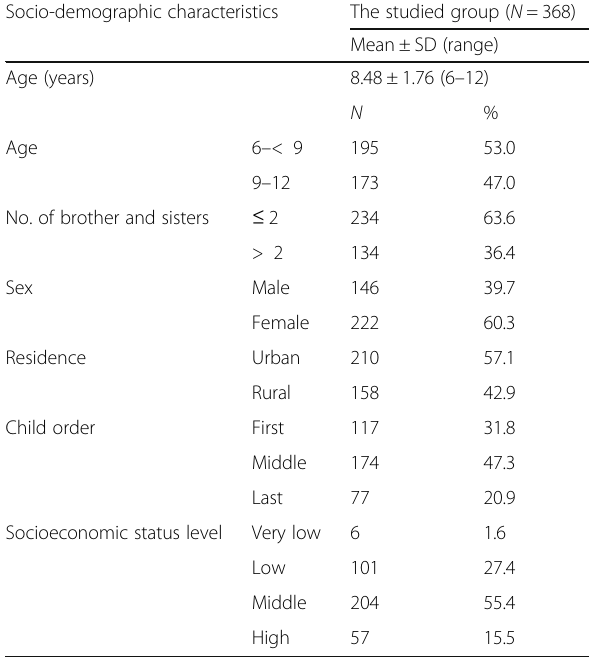
Table 2 Socio-demographic characteristics of the studied group Socio-demographic characteristics